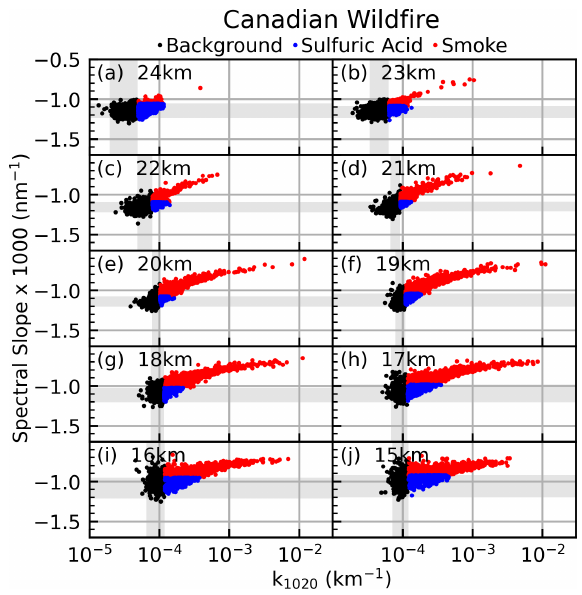
Figure 8. Same as Fig. 4, but for the Canadian wildfire. Figure 9. Same as Fig. 4, but for the Australian